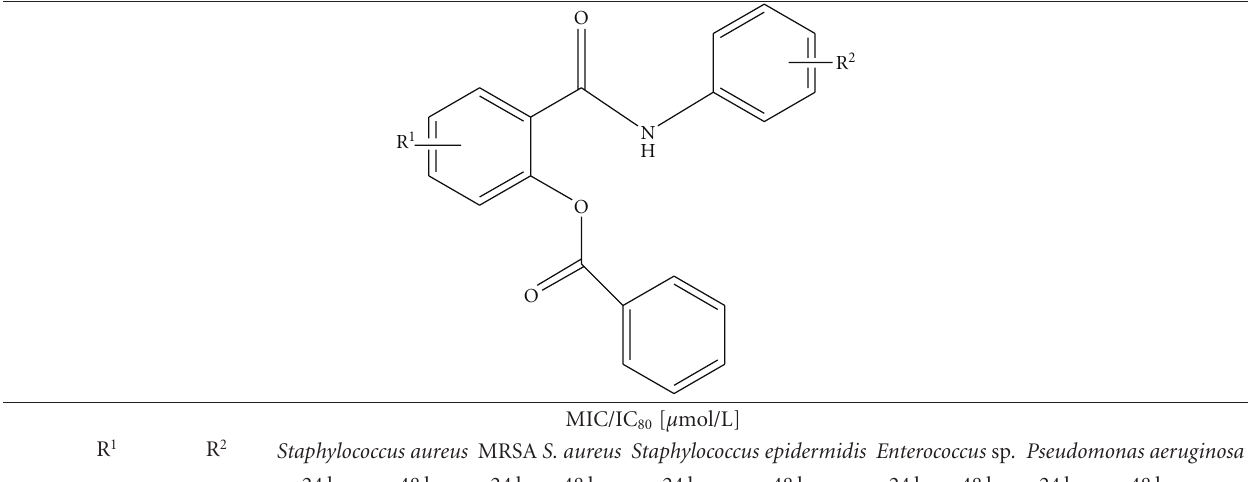
Table 1: Antibacterial activity of benzoates 1-18